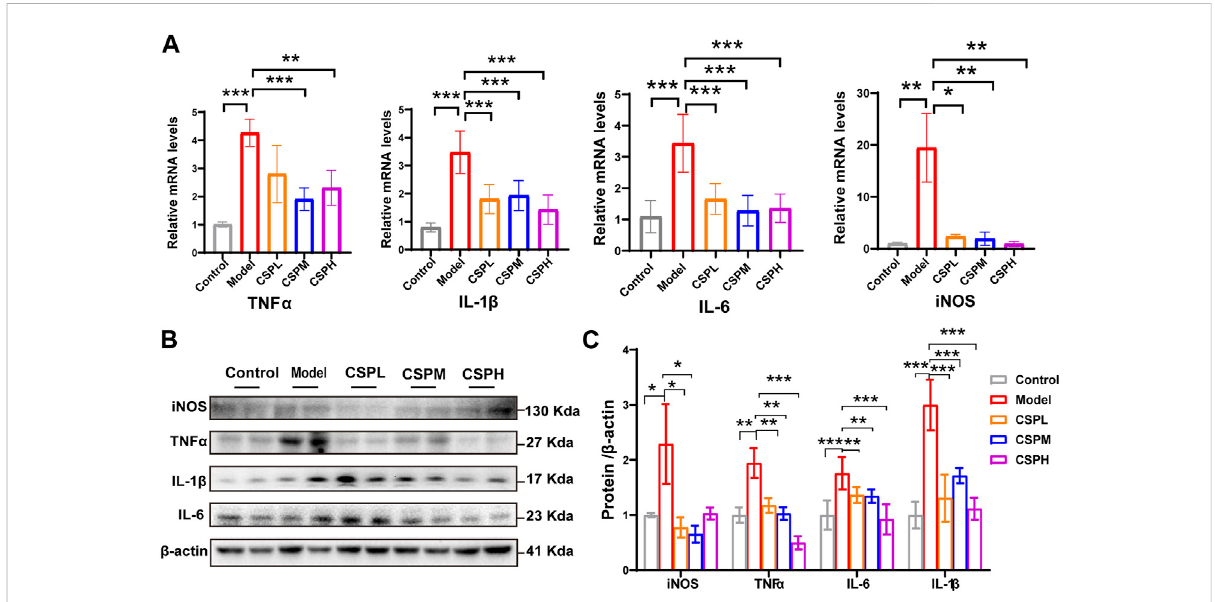
FIGURE 5 CSP inhibits in fl ammatory cytokines in the liver of a mouse model of NAFLD. (A) TNF α , IL-1 β , IL-6, and iNOS expression levels in the liver measured by RT-PCR analyses; (B) Western blot analyses of TNF α , IL-1 β , IL-6 and iNOS with β -actin as a loading control; (C) Densitometric analyses ofbandintensitiesnormalizedto β -actin.Data (A,C) arepresented asthemeans±s.d. * p < 0.05, ** p < 0.01,*** p <